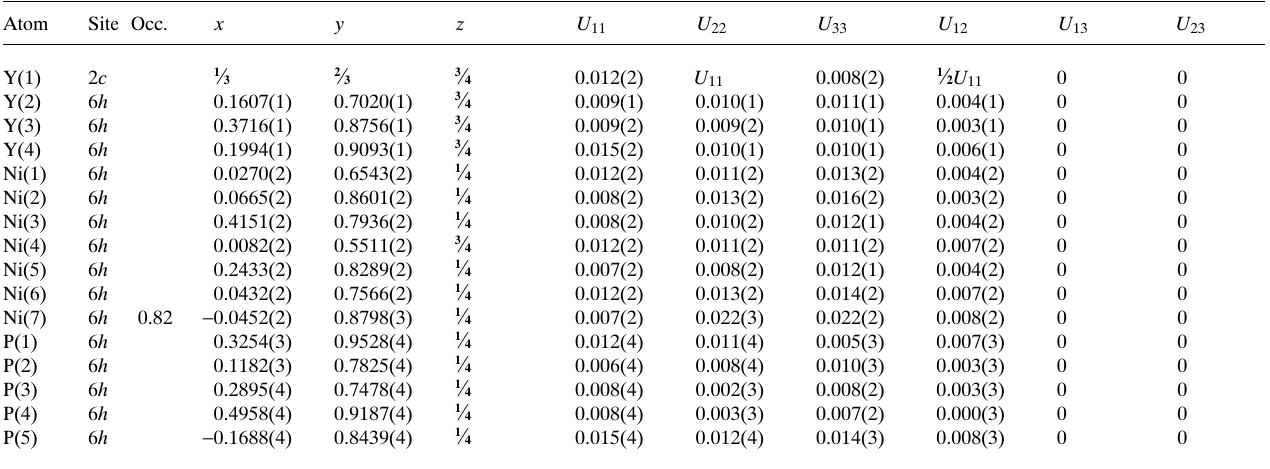
Table 3. Atomic coordinates and displacement parameters (in Å 2 ) .